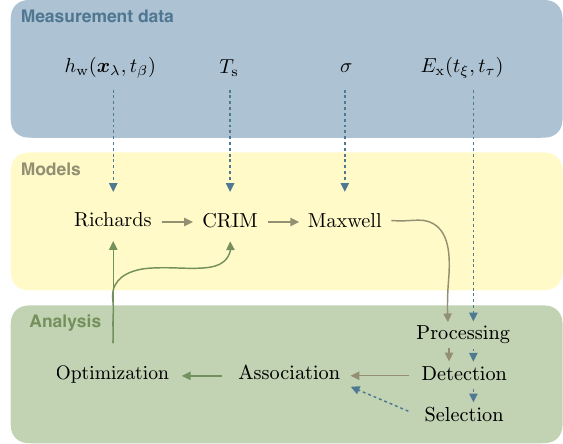
Figure 8. The general setup of the optimization is sketched with this figure. The available hydraulic potential h wt is measured at the po- sition of the groundwater well x λ times t β . These measurements are used as a boundary condition for the Richards equation (Sect. 2.2.1). Estimates for the soil temperature T s and the electrical conductivity σ are derived from TDR-related measurements. The actual signal of the GPR system is proportional to the x component of the electric field E x and measured discretely at experiment time t ξ and sig- nal travel time t τ . This signal is processed (Sect. 2.3.1) and used for event detection (Sect. 2.3.2). Based on the detected events in the measurement data, other events can be either added or deleted in the subsequent event selection step (Sect. 2.3.3). The simulated water content distribution is converted to relative permittivity distribution with the CRIM and used to solve Maxwell’s equations (Sects. 2.2.4 and 3.1.1). After the processing step and the event detection, the simulated events are assigned to measured events (Sect. 2.3.4). The resulting mapping of the events is used to calculate the cost in the optimization step (Sect. 2.4). Dashed arrows indicate initial process- ing steps, whereas solid arrows indicate iterative steps required for the